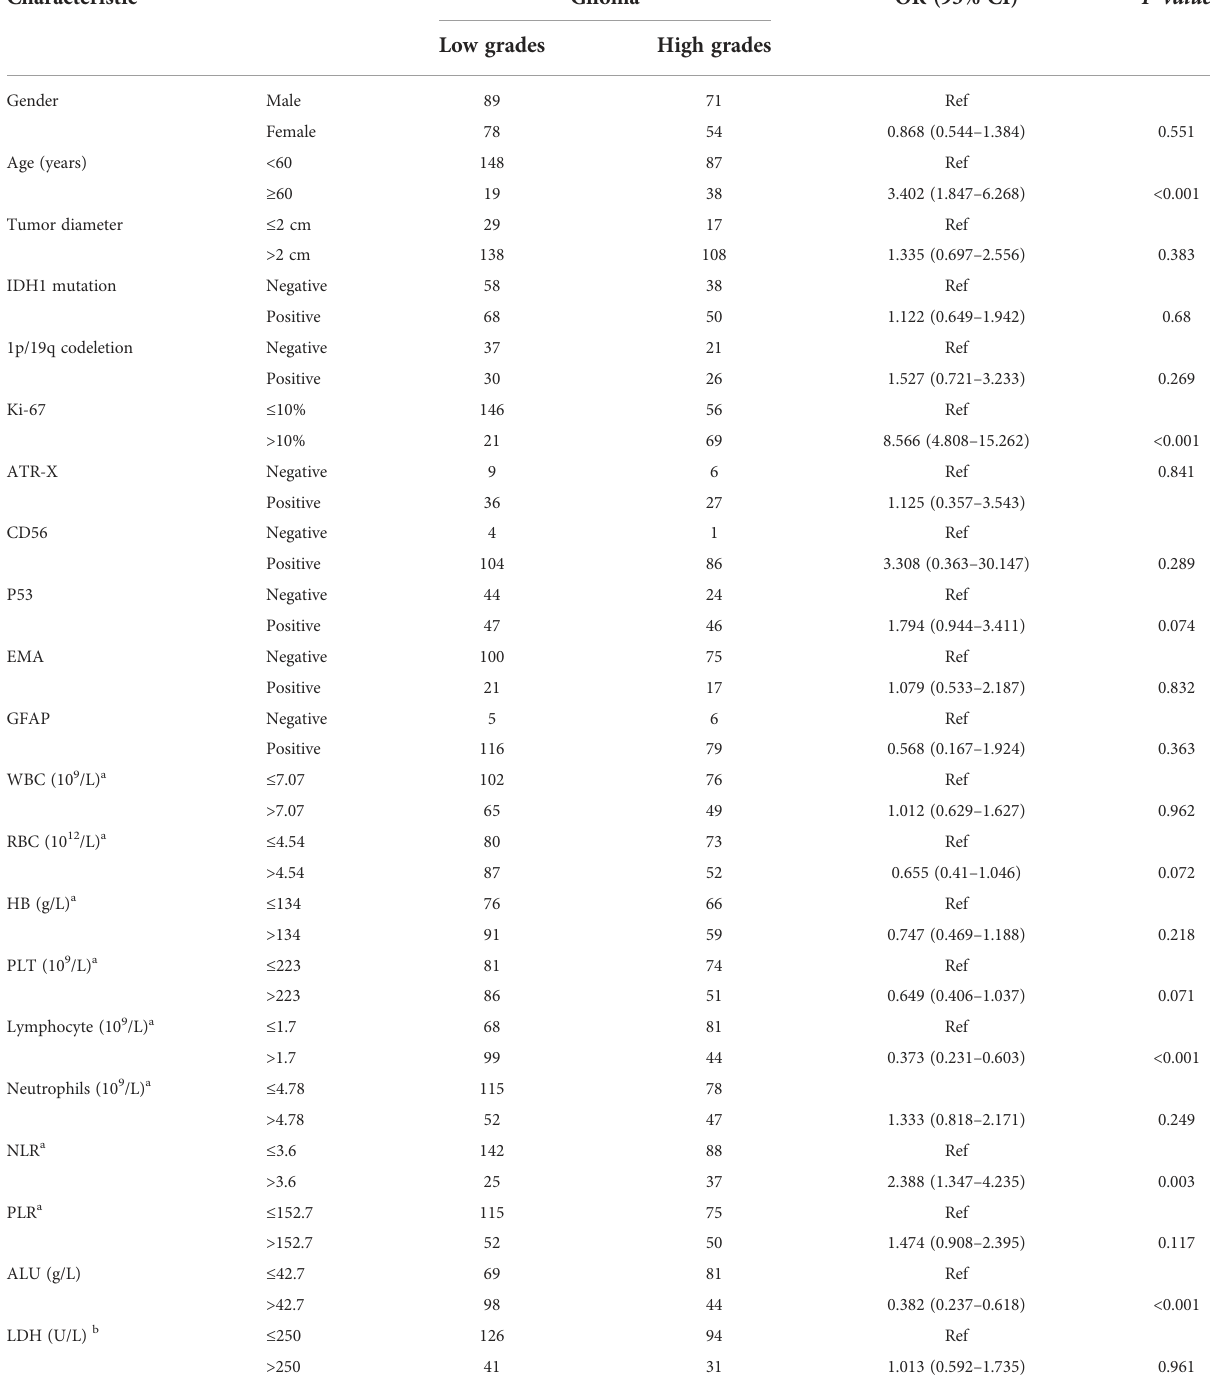
TABLE 2 Univariate logistic proportional hazards regression analysis in the training cohort. Characteristic Glioma OR (95% CI) P-value Low grades High